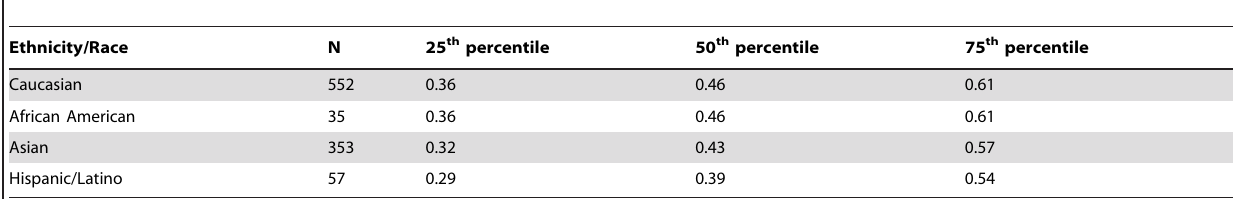
Table 2. Comparison of sub-groups in the 2013 cohort based of self-reported ethnicity/race by the Average Advance Directives Support Score (AADDS).